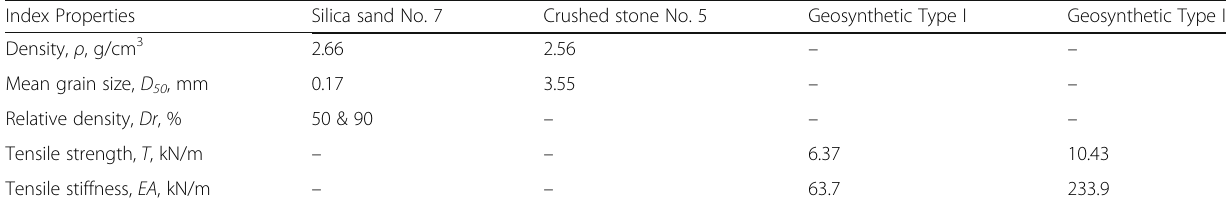
Table 2. The photographs of the model geosynthetics used are shown in Fig.